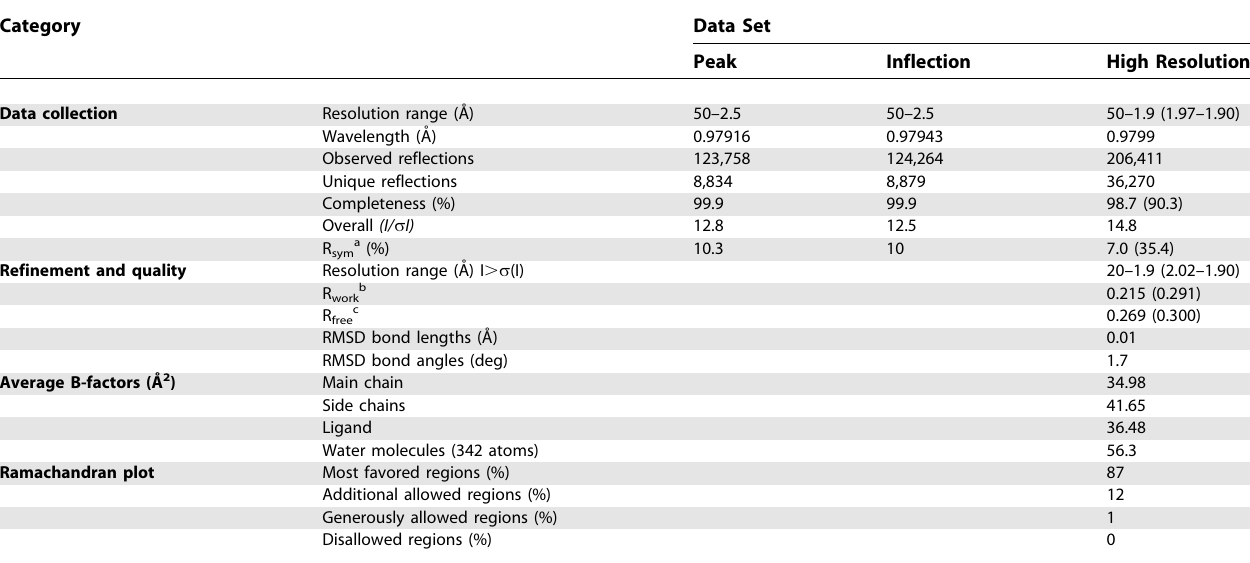
Table 1. Crystallographic Data and Refinement Statistics